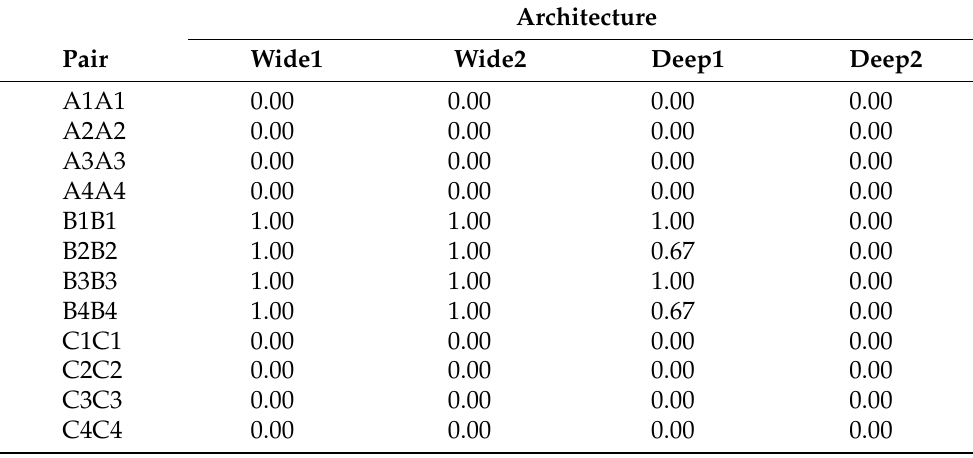
Table 4. Agents’ F1-score by pair in the LS reflexivity